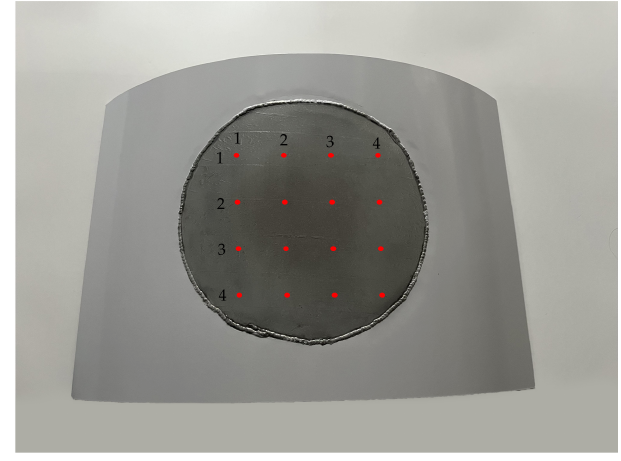
Figure 25. Points for measuring roughness. Figures 26 and 27 display the process for measuring the roughness of each point before and after grinding, respectively.